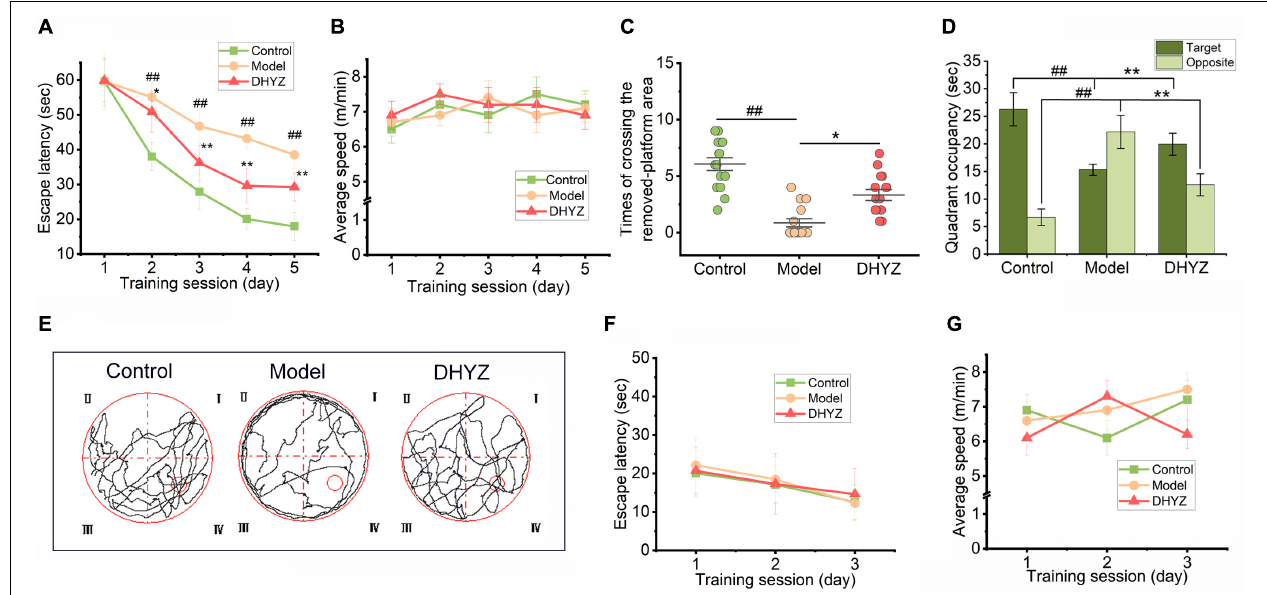
FIGURE 3 | DHYZ treatment improves spatial memory of 2 × Tg-AD mice in the Morris water maze (MWM) test. In the place navigation test, the escape latency (A) and average swimming speed (B) of each group were recorded. In the spatial probe test, the times of crossing the removed platform area (C) , the residence time of the 3 groups of mice in the target quadrant, and the opposite quadrant (D) were assayed, and representative images of the route of travel (E) were recorded. The escape latency (F) and average swimming speed (G) in the visible-platform test were measured. All data are presented as the mean ± SEM ( n = 18 mice per group). ## P < 0.01, model vs. control; * P < 0.05 and ** P < 0.01, DHYZ vs. model. AD, Alzheimer; DHYZ,